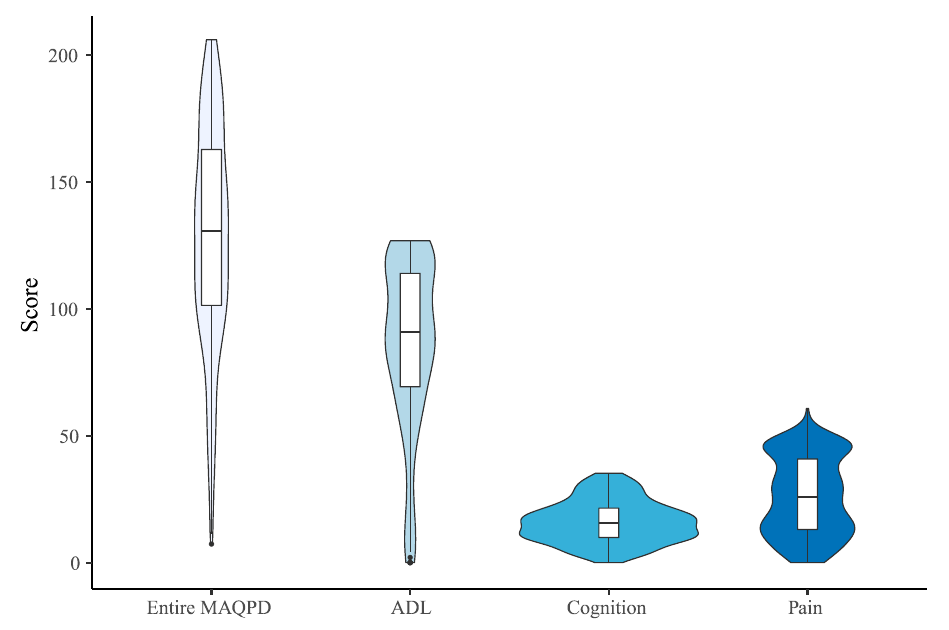
Figure 4. Violin plot of the final scores. The histogram and cumulative probability distribution function of the individuals’ final scores are depicted in Figure 5.